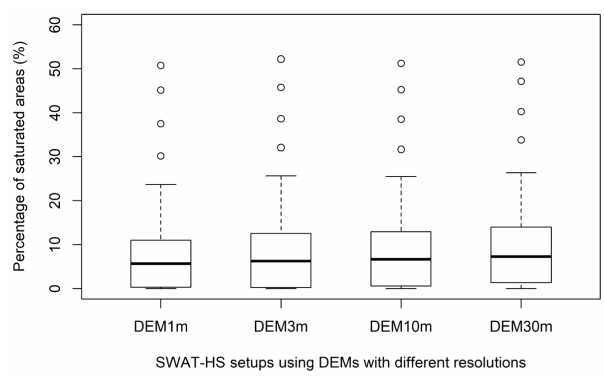
Figure 7. Percentage of saturated areas taking into account param- eter uncertainty in the calibration period in SWAT-HS setups using DEMs with different